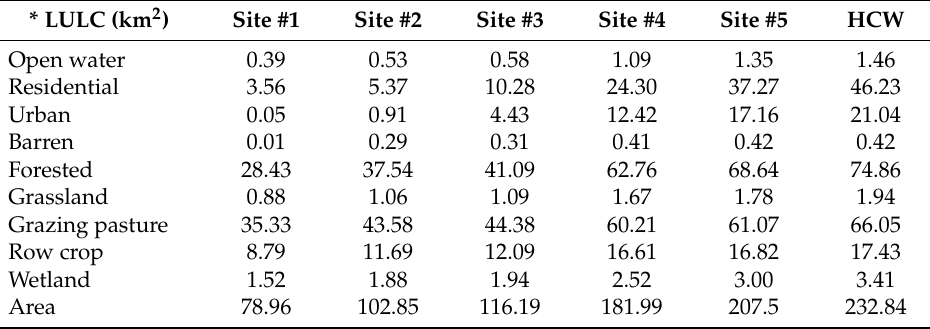
Table 1. Cumulative drainage area, land use and land cover (LULC) area (km 2 ) to each gauging site located in Hinkson Creek Watershed (HCW), MO, USA. “HCW” is cumulative of Sites